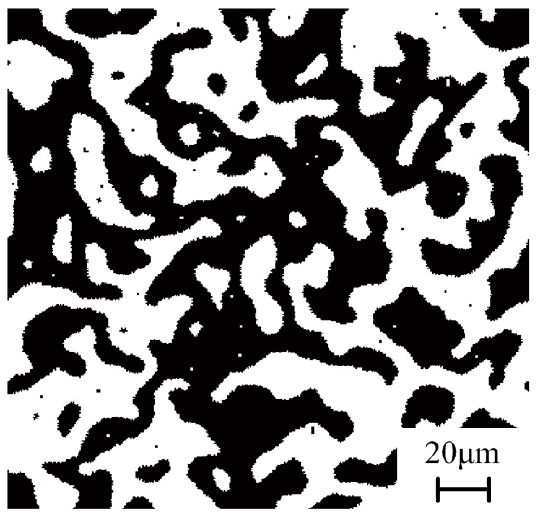
Figure 5. Initial microstructure distribution of 1045 steel workpiece.